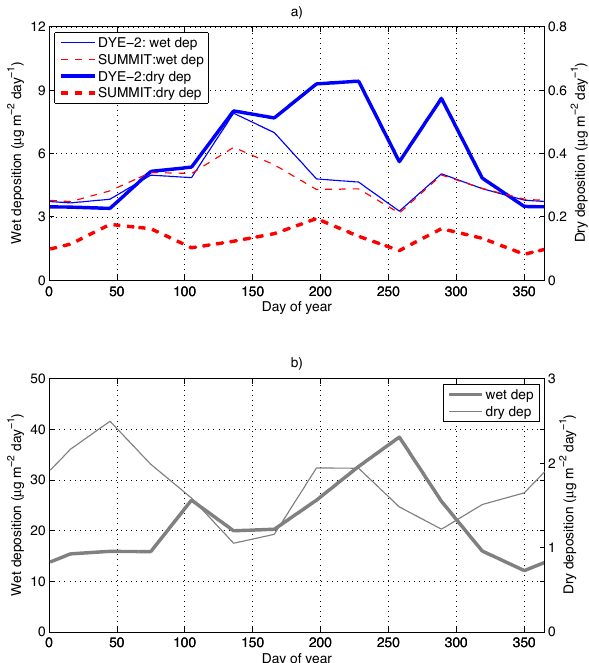
Figure 1. Examples of prescribed wet (left axis) and dry (right axis) BC mass deposition fluxes in CAM4 for year 2000 for (a) two model grid boxes in Greenland containing the Dye-2 (69.2 ◦ N, 315.0 ◦ E) and Summit research stations (72.3 ◦ N, 321.7 ◦ E), and (b) a single model grid box in northern Eurasia (71.1 ◦ N, 85.0 ◦